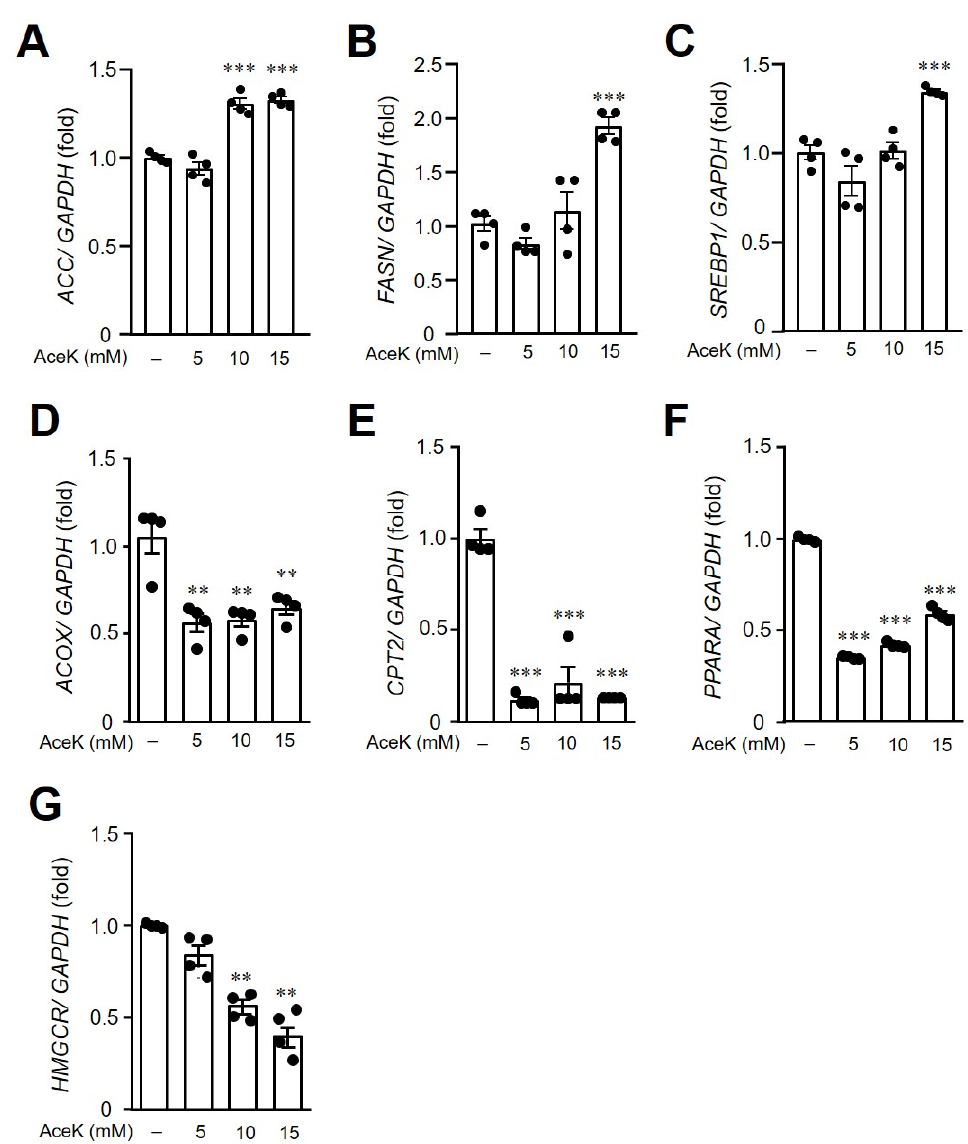
Figure 5. Effects of AceK on lipid metabolism-related gene expressions in HepG2 cells. HepG2 were treated with indicated doses of AceK for 24 h. The cells were then harvested and RNA was isolated for the quantification of acetyl-coA carboxylase ( ACC ) ( A ), fatty acid synthase ( FASN ) ( B ), sterol regulatory element binding protein-1 ( SREBP1 ) ( C ), peroxisomal acyl-coenzyme A oxidase ( ACOX ) ( D ), carnitine palmitoyltransferase-2 ( CPT2 ) ( E ), peroxisome proliferator-activated receptor- α ( PPARA ) ( F ), and 3-hydroxy-3-methyl-glutaryl-coenzyme A reductase ( HMGCR ) ( G ) gene expressions by quantitative PCR ( n = 4). ** p < 0.01, *** p < 0.001.